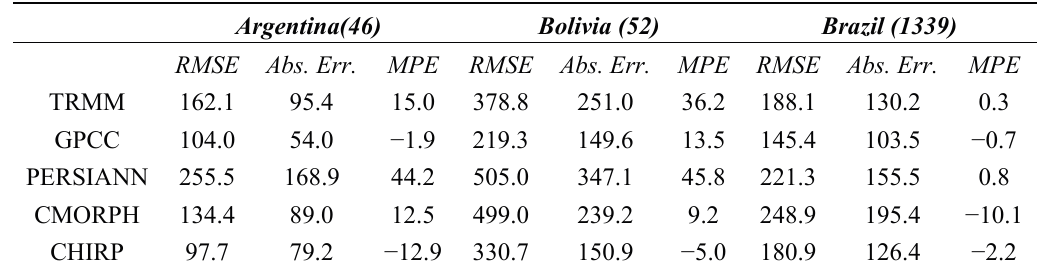
Table 2. Statistical indicators of Satellite-derived dataset versus rain gauge stations across nine validation countries. Numbers in parentheses in the first row refer to the number of rain gauge station employed for each